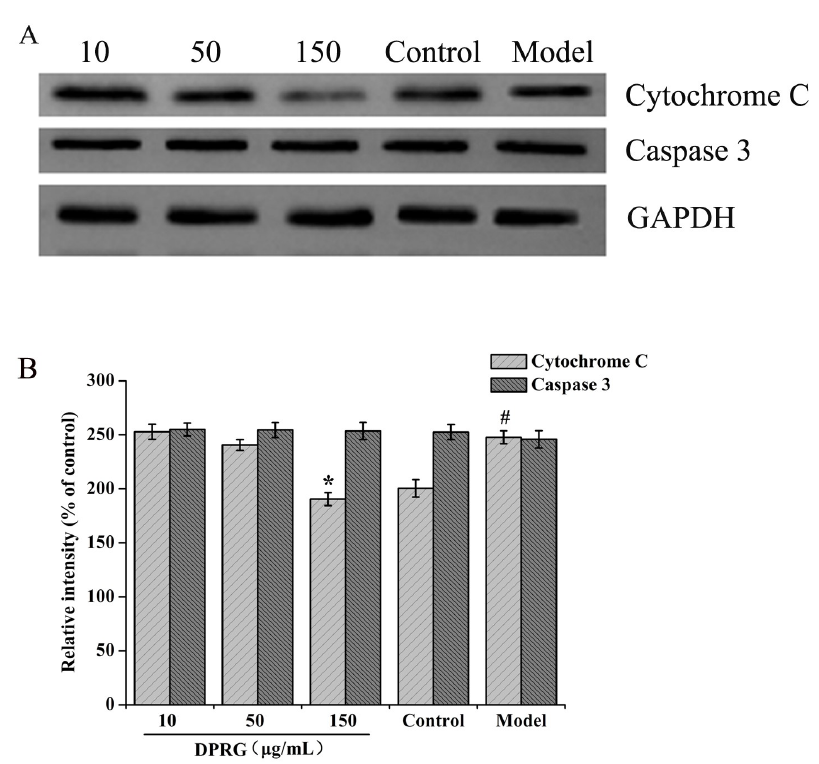
Figure 8. The related protein expression in Aβ 25-35 -treated PC12 cells. The protein expression of Cytc and caspase 3 in damaged cells ( A ). Quantification analysis ( B ) of the relative levels of Cytc and caspase 3 normalized to GAPDH. The values are presented as means ± S.D, n = 3. # p < 0.05, compared to control group; * p < 0.05 compared to model